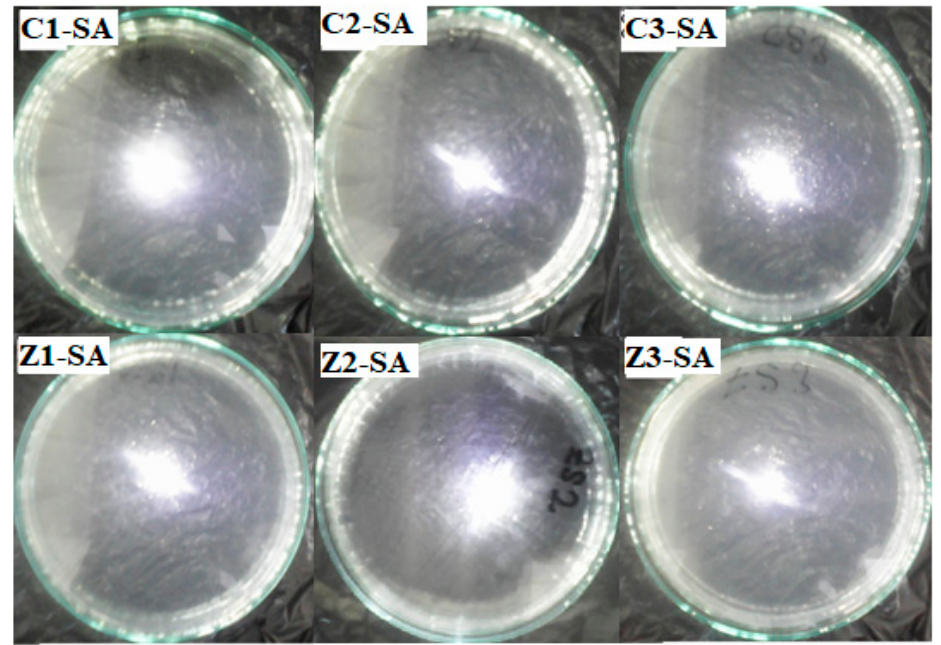
Figure 26. Antibacteria activity of clay/CuO/Ag and clay/ZnO/Ag against S. aureus in water after 48 h of incubation. C1-EC, C2-EC, C3-EC correspondingly relates to clay/CuO/Ag-1, clay/CuO/Ag-2 and clay/CuO/Ag-3 against S. aureus . Z1-EC, Z2-EC, Z3-EC correspondingly relates to clay/ZnO/Ag-1, clay/ZnO/Ag-2 and clay/ZnO/Ag-3 against S. aureus .